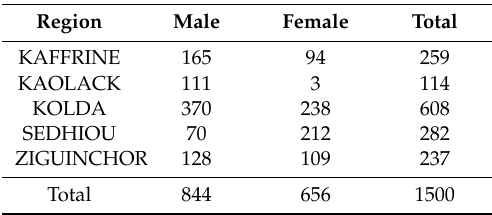
Table 2. Sample by region and sex.